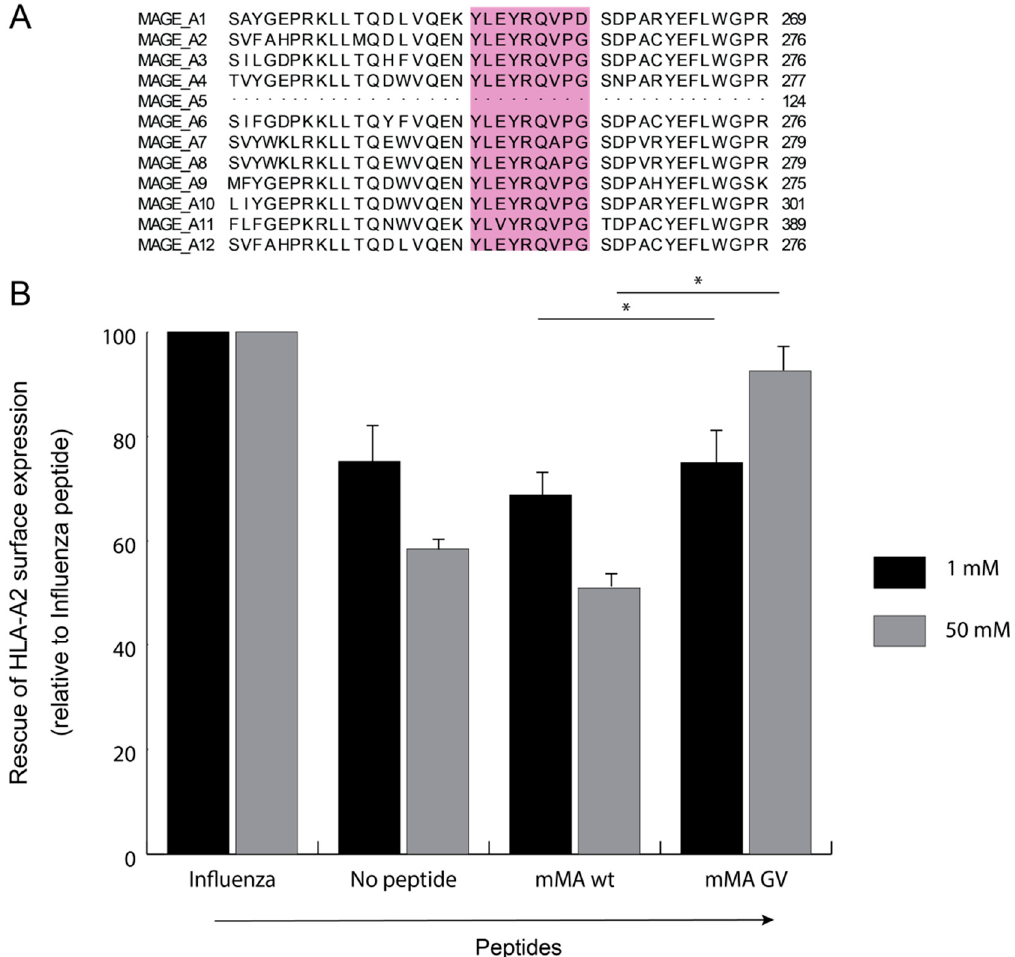
Figure 1. Presence of mMA among various MAGE-A genes and binding of wild type or heteroclitic mMA peptide to HLA-A2. ( A ) Shared 9 amino acid sequence among MAGE A1 to A12 antigens. ( B ) T2 cells were pulsed with titrated amounts of control Influenza (HLA-A*201 restricted influenza M 58-66 GILGFVFTL peptide), mMA (wt, YLEYRQVPG), mMA (GV, YLEYRQVPV) or no external peptide. Flow cytometry was performed as described in the MM section. MFI values were normalized against those observed with Influenza peptide. Data are presented as mean percentage (at 1 and 50 mM concentrations) and standard error of mean, n = 5. Statistical significance is calculated with Kruskal–Wallis test among all groups: 1 mM p = 0.007 and, 50 mM p = 0.008. Individual non-parametric significance between mMA-GV and mMA-wt is calculated using Mann–Whitney U test; *: p <